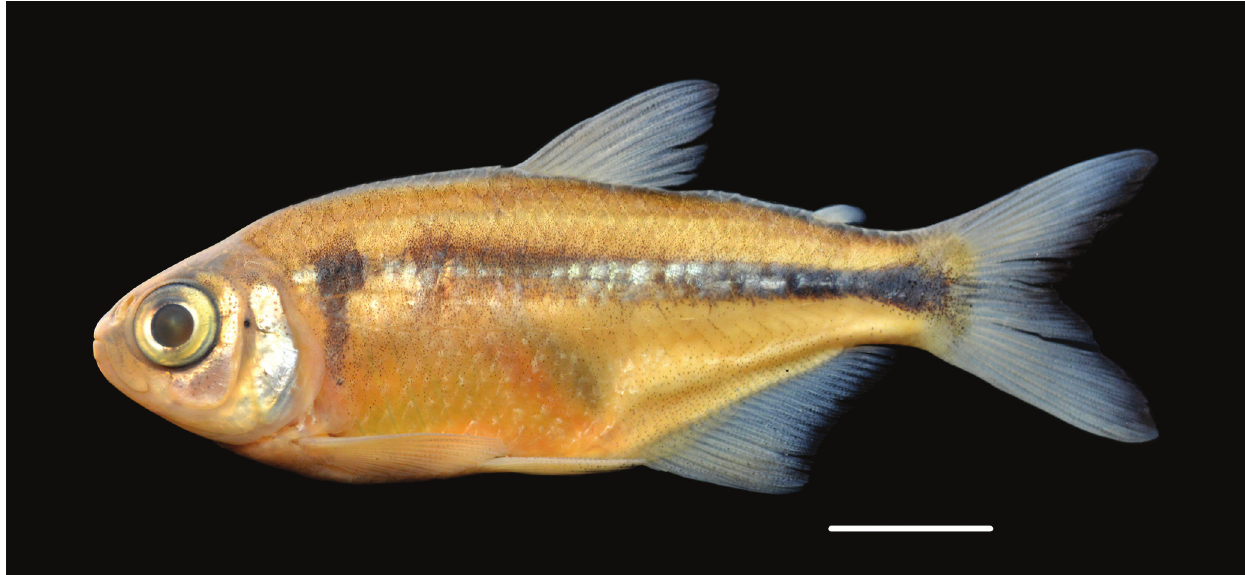
Fig. 1. Astyanax powelli , new species. CI-FML 6797, holotype, 52.3 mm SL, Argentina, Catamarca province, Río Sucuma. Scale bar = 10